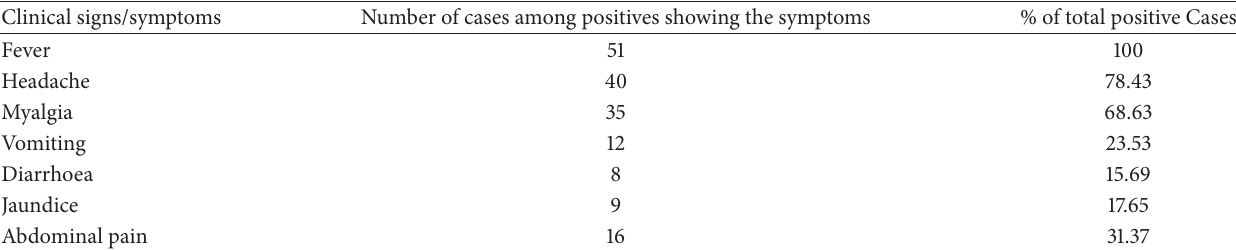
Table 3: Clinical features in leptospirosis.